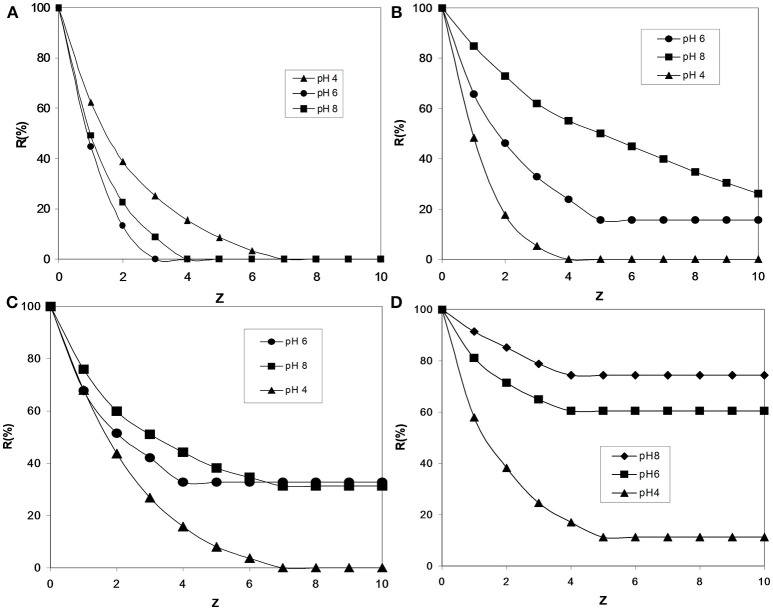
Retention profile of As(V) by poly[(3-methacryloylamine)propyl)trimethyl ammonium chloride-co-acrylic acid] [P(ClMPTA-co-AA)] at different monomer molar ratios of (a) 1:1, (B) 1:2, (C) 2:1, and (D) 4:1. The polymer amount is 0.2 mmol, and the absolute amount of As(V) ions is 0.01 mmol. Adapted from Rivas et al. (2006), Rivas and Aguirre (2007).